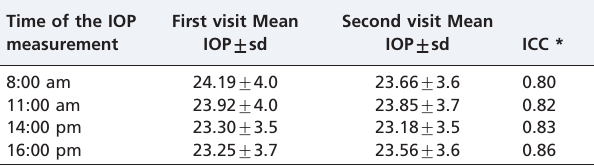
Table 1 - Mean Intraocular Pressure Values at Each Visit and Time